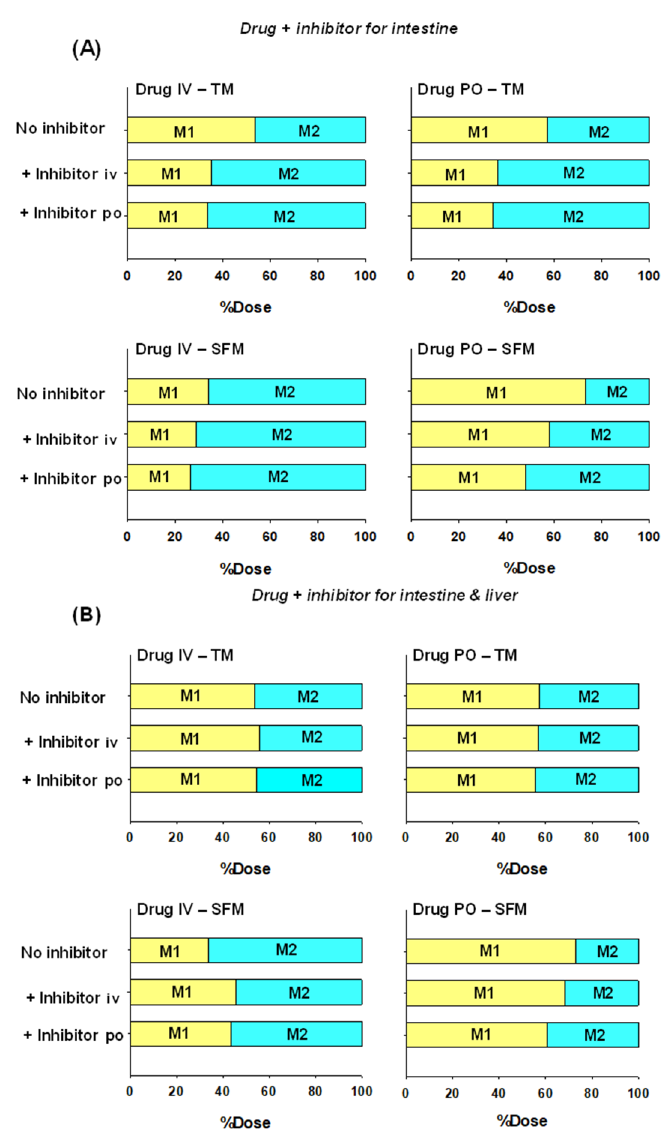
Figure 6. Simulation of intestinally (M1) and hepatically (M2) formed metabolites. For simulation, M1 and M2 were assumed to be inhibited within the intestine only ( A ), and both the intestine and liver ( B ) for a drug example ([18]; data in Table 6 of the reference). The simulation showed that the SFM predicted the highest and lowest M1 formation after oral and intravenous drug admintration, respectively, and the TM predicts a similar extent. The inhibition on intestinal metabolism is the greatest when both the inhibitor and drug are given orally, as predicted by the SFM ( A ). When both intestine and liver metabolism is inhibited, the pattern of change is not readily predictable ( B ). A greater liver inhibition exists after iv drug administration, and the extent of inhibition within the liver can exceed that in the intestine ( B ). This figure was reproduced with permission from data in Table 6 of Noh and Pang [18], Wiley, 2019.